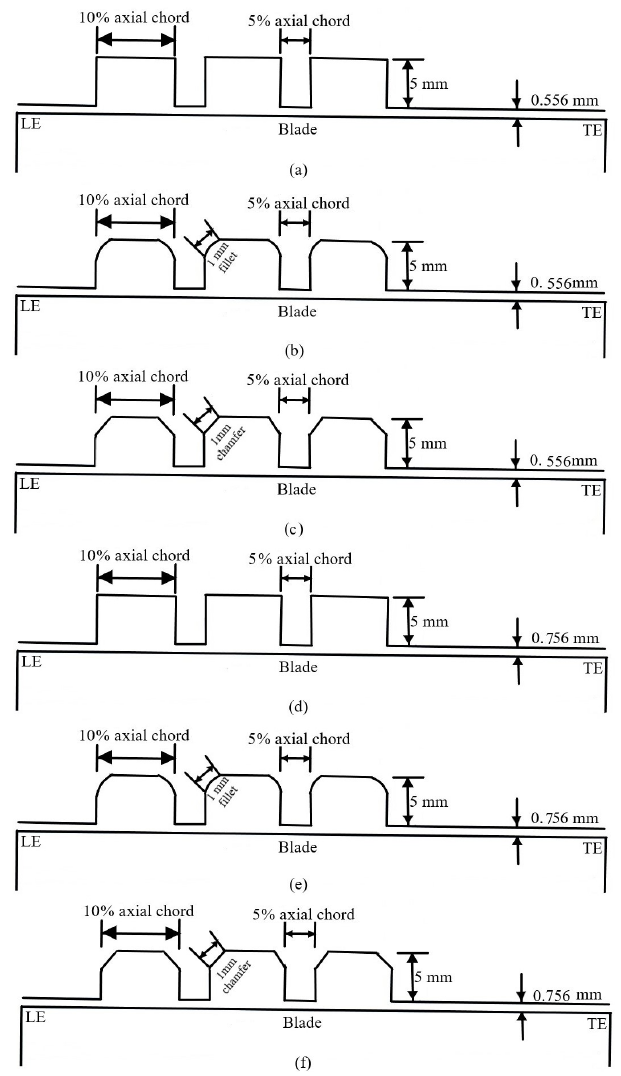
Figure 2. Circumferential grooves with various shapes and with various tip gap models 1–6.